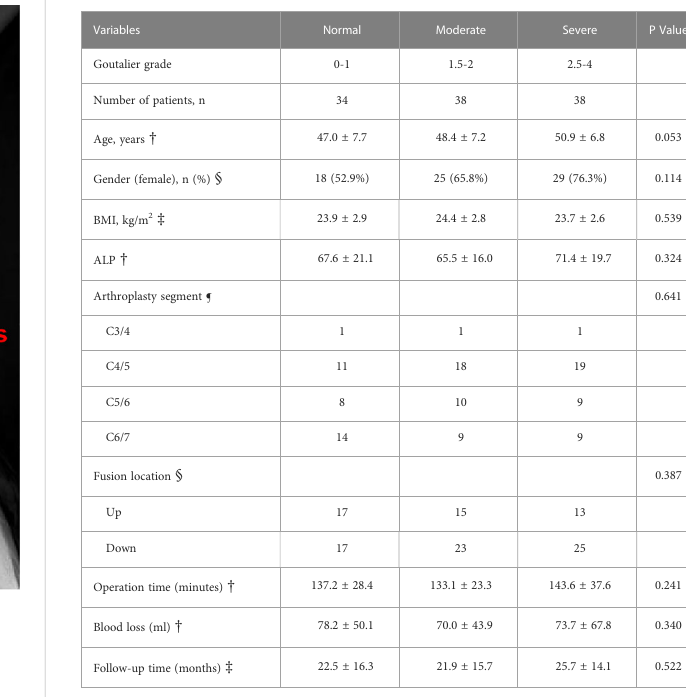
TABLE 1 Demographic and perioperative